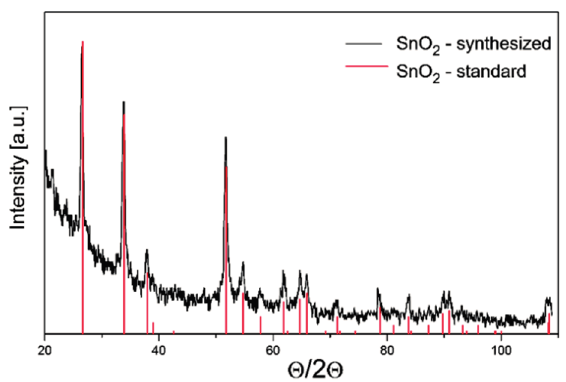
Figure 3. X-ray diffractograms of the standard SnO 2 and the powder SnO 2 obtained by the authors.